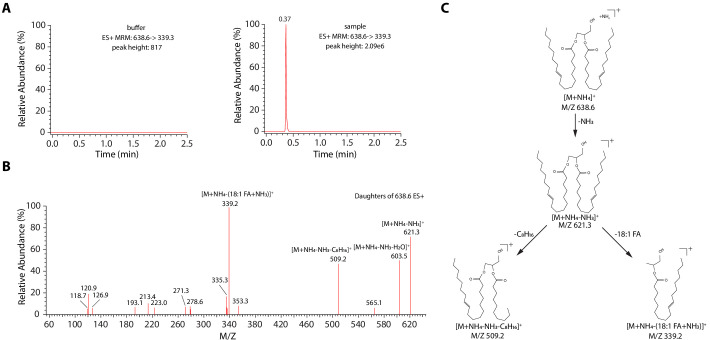
The identification of diacylglycerol (DAG) molecule in protein sample.(A) The HPLC chromatography of DAG (18:1-18:1) under the MRM transition 638.6 -> 339.3 from buffer (left), and human TRPC5 (hTRPC5) sample (right). (B) MS/MS spectrum of lipid extractants from hTRPC5 sample. (C) Potential MS/MS fragmentation pattern of DAG, using 1,2-DAG as an example.